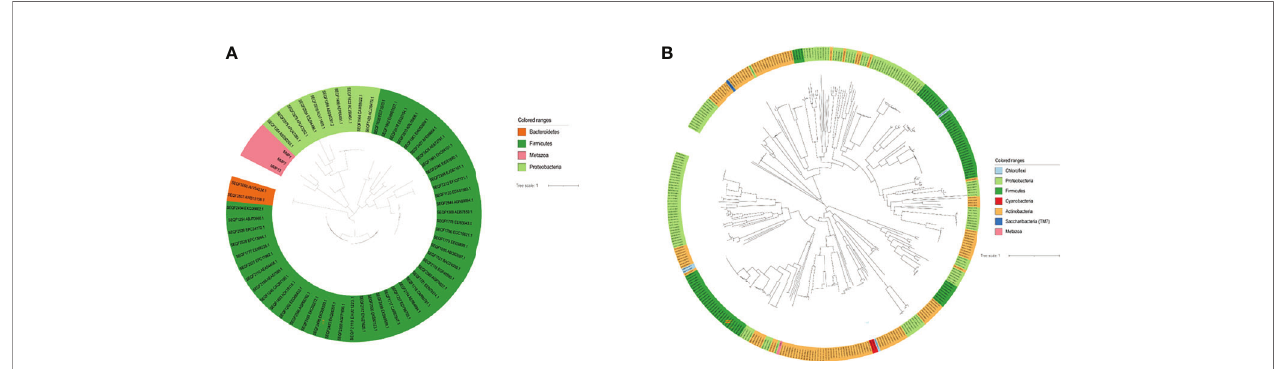
FIGURE 3 | The evolutionary relation analysis of Top DEGs. (A) The evolutionary relation between MMP13, MMP7, and MMP1 with the microbiome. (B) The evolutionary relation between CYP3A4 with